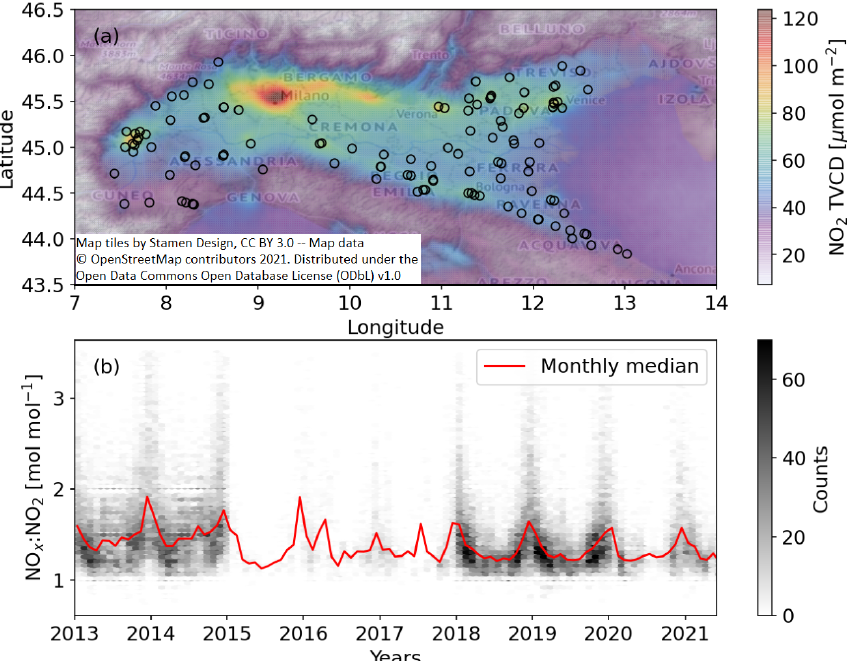
Figure 11. (a) Black circles are the locations of ground-based observation sites where NO x and NO 2 data are available. TROPOMI NO 2 TVCD from May 2018 to May 2019 oversampled to a 0 . 02 ◦ grid is illustrated in the background. (b) The background shows the density of available NO x : NO 2 ratios from filtered hourly ground-based measurements. The red line shows the monthly median values.